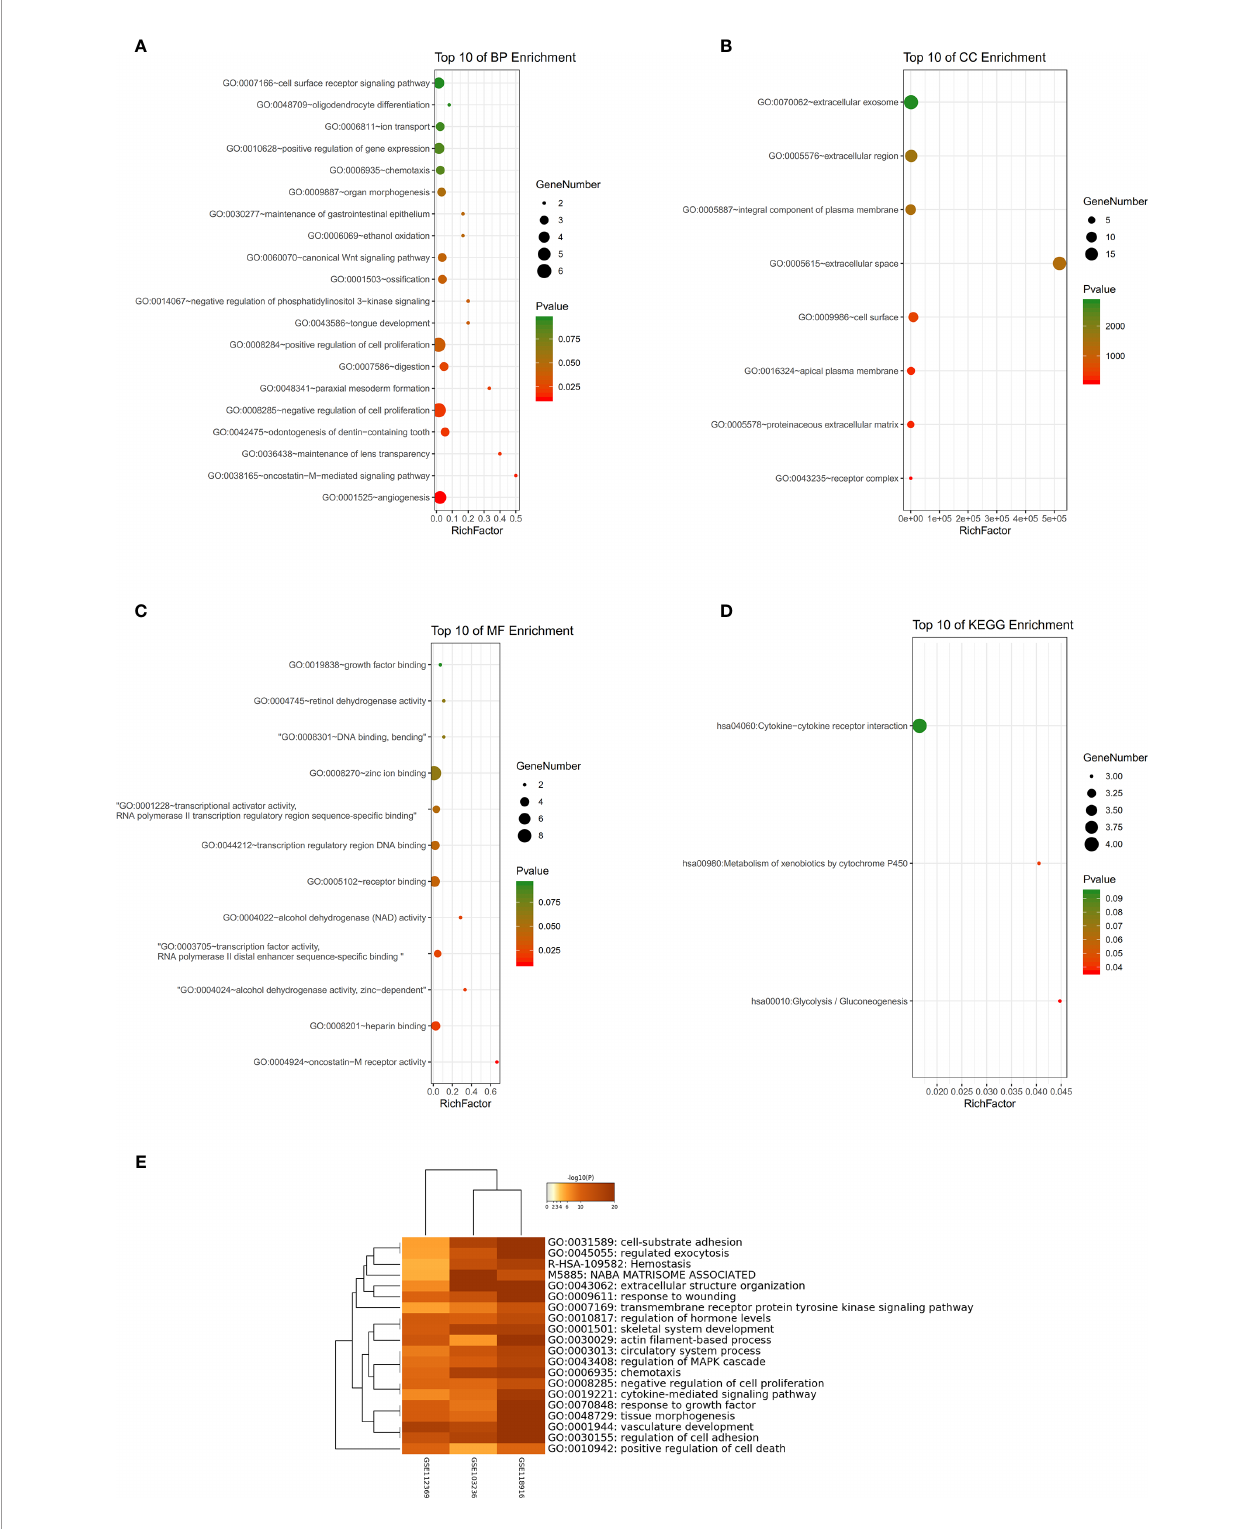
FIGURE 5 | (A – C) Detailed information relating to changes in the biological processes (BP), cellular components (CC), and molecular functions (MF) of DEGs in gastric cancer and control tissues through the GO enrichment analyses. (D) The KEGG pathway analysis of DEGs. KEGG, Kyoto Encyclopedia of Genes and Genomes; GO, Gene Ontology; DEGs, differentially expressed genes. (E) Histogram of enriched terms across input differently expressed gene lists, colored by p-values, via